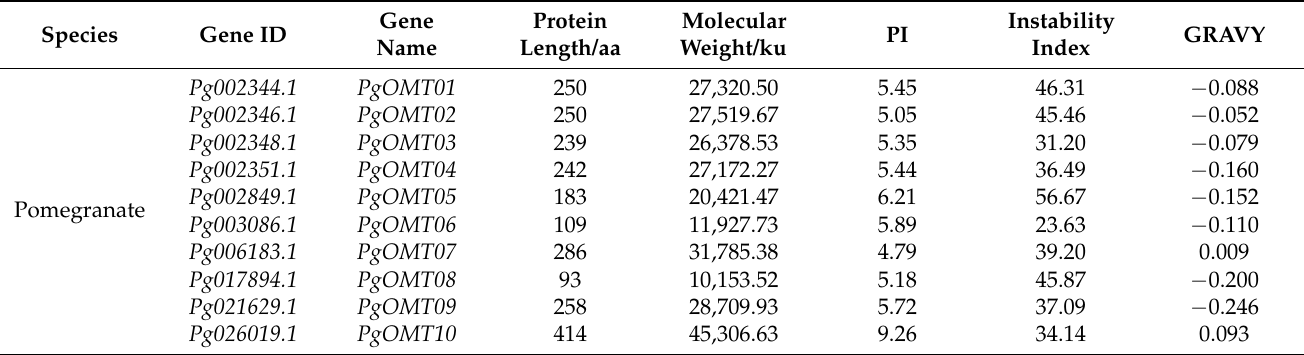
Table 1. The basic information of PgOMT gene